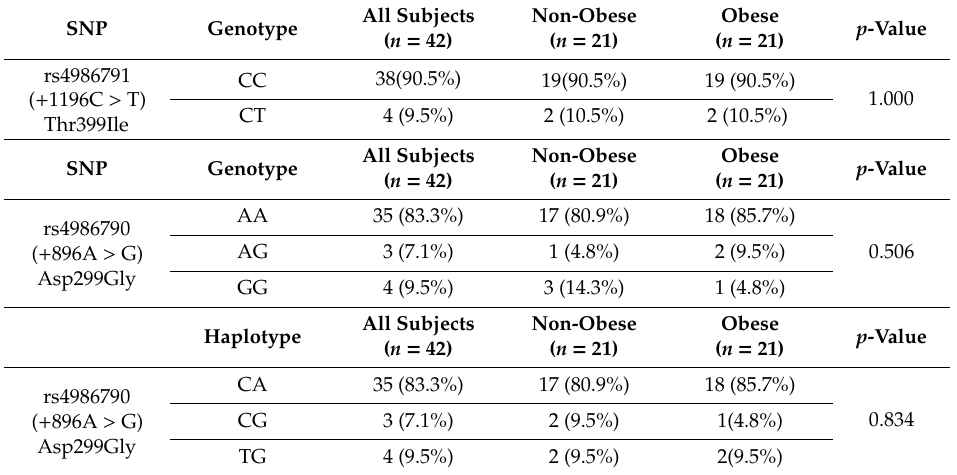
Table 4. Genotype and haplotype distribution of rs4986791 and rs4986790 in the cohort of non-obese group versus obese subjects included in monocyte TLR4 expression